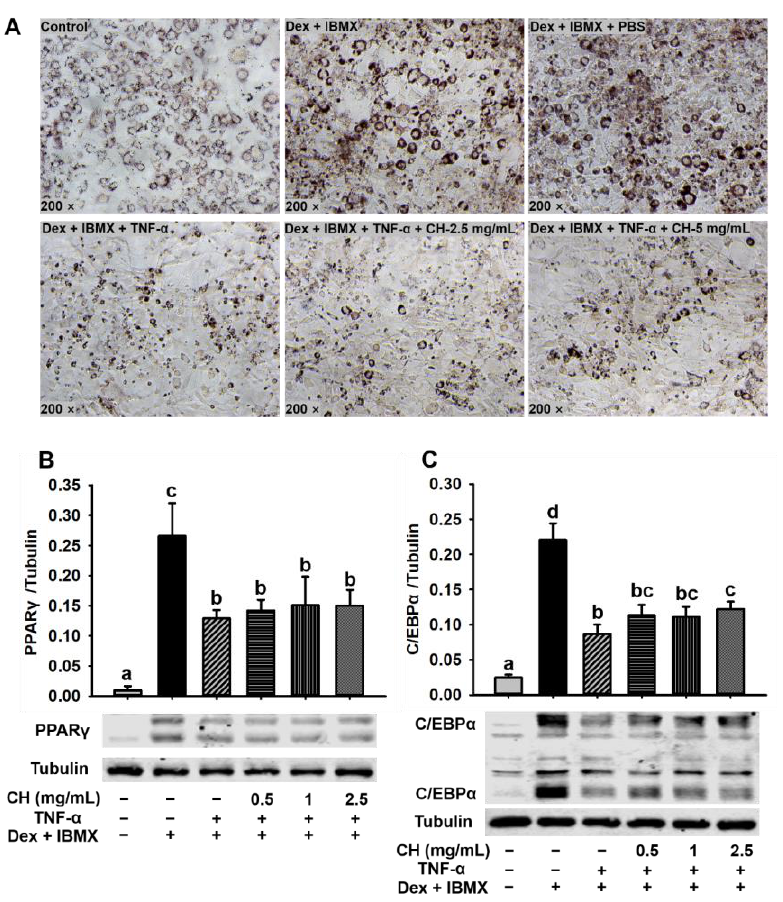
Figure 7. CH alleviated impaired adipocyte differentiation induced by TNF-α. 3T3-L1 were incubated in a differentiation medium containing 2.5 mg/mL and 5 mg/mL CH for 1 h, followed by the treatment of 10 ng/mL TNF-α for 24 h, and then refreshed with a new differentiation medium with or without CH after 48 h and 72 h, respectively. Oil red O staining was used to detect the accumulation of lipid droplets during cell differentiation ( A ). 3T3-L1 cells were seeded in 6-well plates, and incubated in differentiation medium containing 0.5, 1 and 2.5 mg/mL CH for 1 h, respectively. Then 10 ng/mL TNF-α was added and incubated for 24 h. Then, new differentiation medium containing the corresponding CH were refreshed and cultured for another 48 h and 72 h. The expression levels of PPAR-γ ( B ) and C/EBPα ( C ) were detected by western blot analysis. Different superscript letters in each column indicated statistically significant difference at p < 0.05.